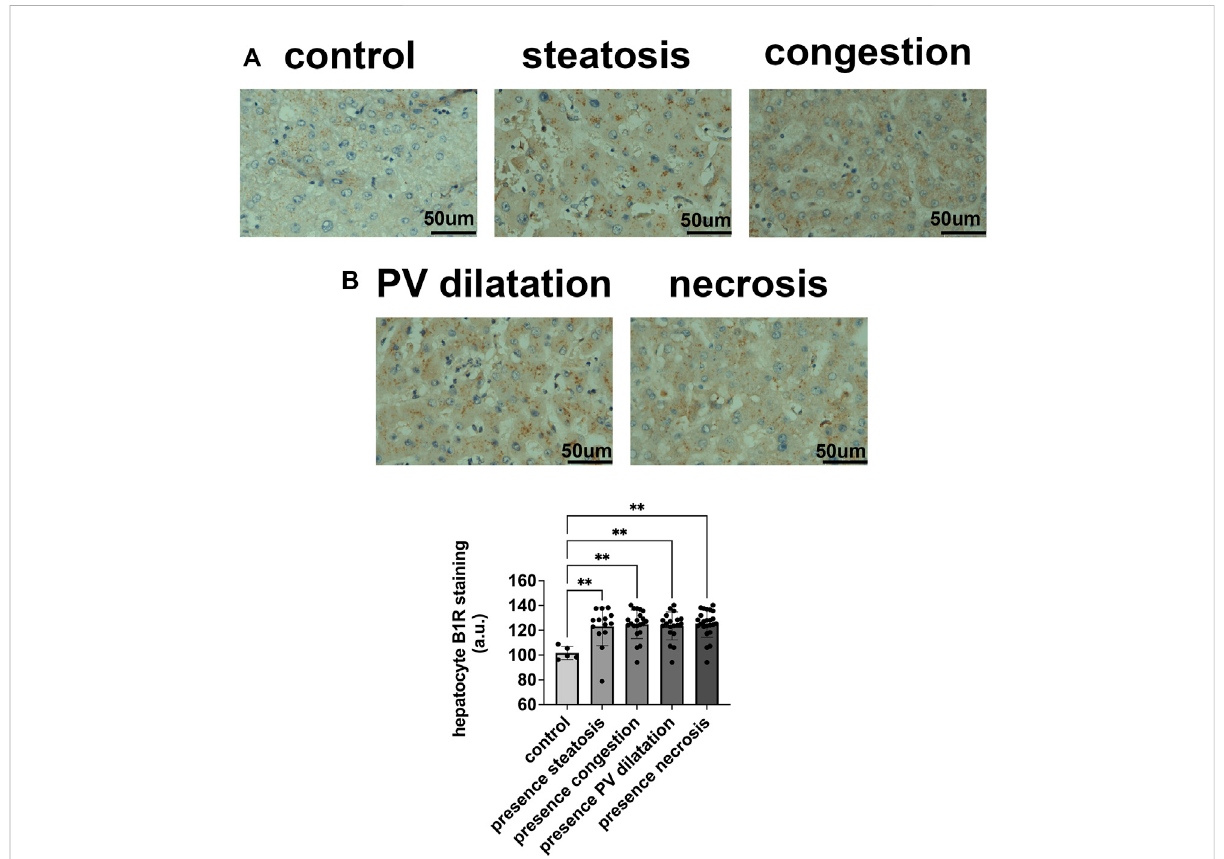
FIGURE 4 B1R expressionin hepatocytes in COVID-19 patients and its correlation with patterns of liver injuries. (A,B) . B1R in the liver of control individuals ( n = 5) and COVID-19 patients ( n = 25); Comparison between B1R expression level in the liver of 5 control individuals (101.6 ± 5.2 a. u.) and liver